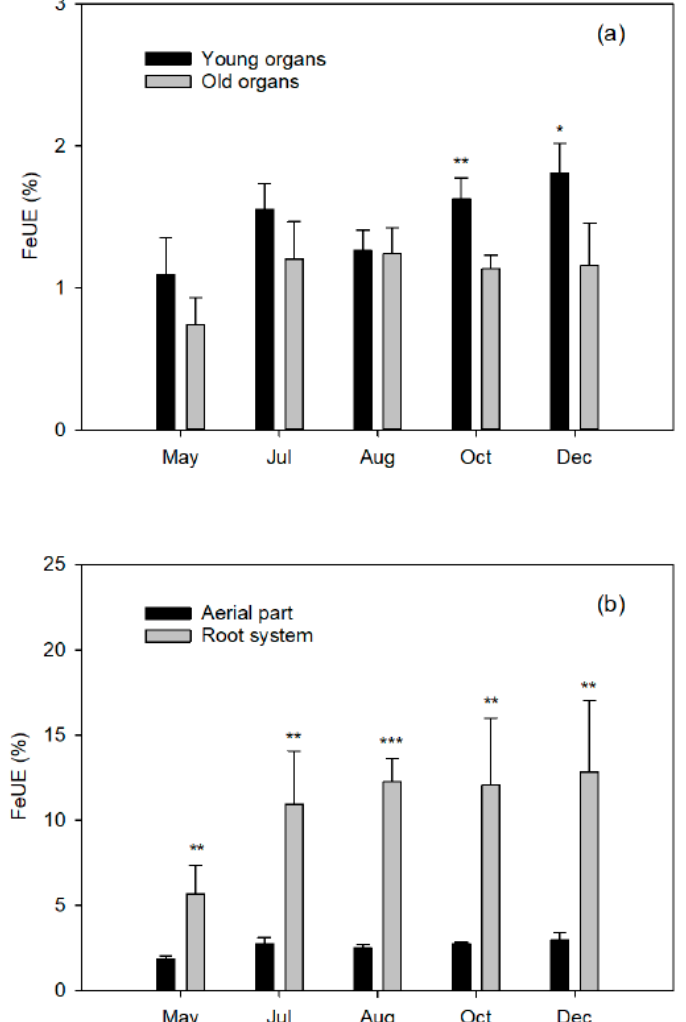
Figure 6. Fe use efficiency (FeUE W , %) in ( a ) young Z and old Y organs from the aerial part in relation to the whole plant and ( b ) aerial part and root system X of Nules clementine trees uprooted in May (flowering), July (fruit set and the end of fruit drop), August (fruit growth), October (fruit growth), and December (fruit maturity). Values are means ± SD (n = 4). Significant effects of Fe dose are given at p ≤ 0.05 (*) and p ≤ 0.001 (***) at each harvest event. Z,Y,X: See Figure 1. W FeUE (%) organ or plant = Σ Feddf (mg) organ or plant × 100 (Table 5)/Fe (mg) applied by fertilizer to every plant from the beginning of the experiment until harvest (Table 7). Low efficiency may be due to two causes: 1) the dose of Fe applied far exceeds the 248 needs for Fe of the plants, which does not seem evident since, according to Table 7, the 249 dose applied is adjusted to the Fe demand of the crop or 2) the soil has a lot of assimilable 250 Fe, which dilutes the 57 Fe supplied, so plants absorb a higher proportion of the Fe available 251 in the soil than that afforded by the chelate. 252 Table 7. Fe and 57 Fe doses and its monthly distribution along the fertilizing period in citrus trees. 253 Mar Apr May Jun Jul Aug Sep Oct Total Fe distribution rate (%)